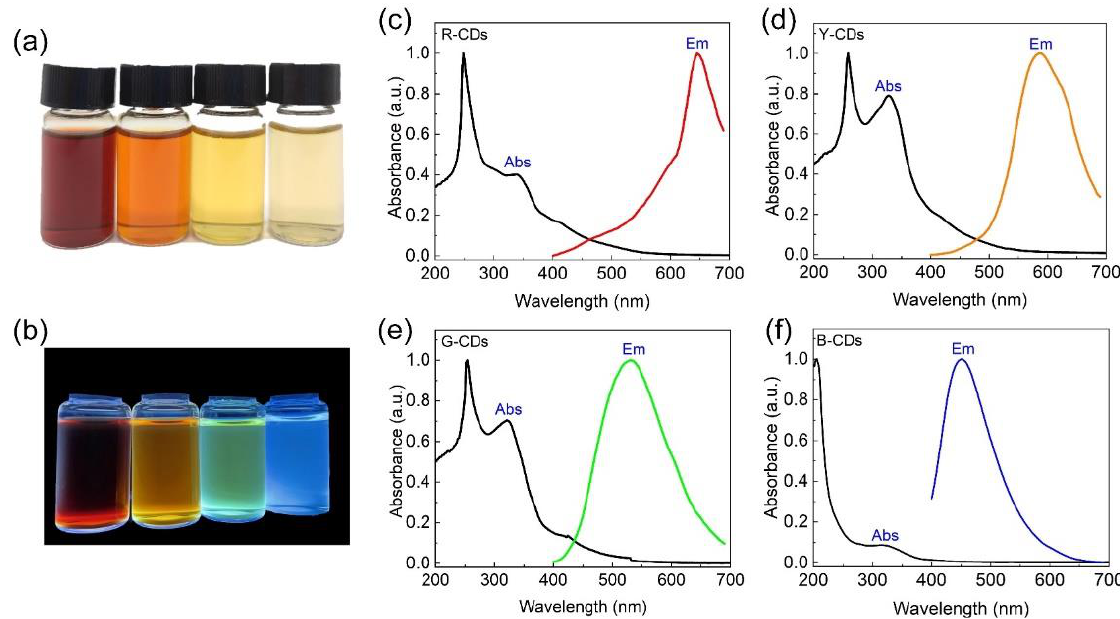
Figure 4. Corresponding photos of the R-CDs, Y-CDs, G-CDs, and B-CDs under sunlight ( a ) and UV light (365 nm) irradiation ( b ), respectively. ( c ) Emission and UV-adsorption spectra of R-CDs. ( d ) Emission and UV-adsorption spectra of Y-CDs. ( e ) PL emissions and UV-adsorption spectra of G-CDs. ( f ) Emission and UV-adsorption spectra of B-CDs.